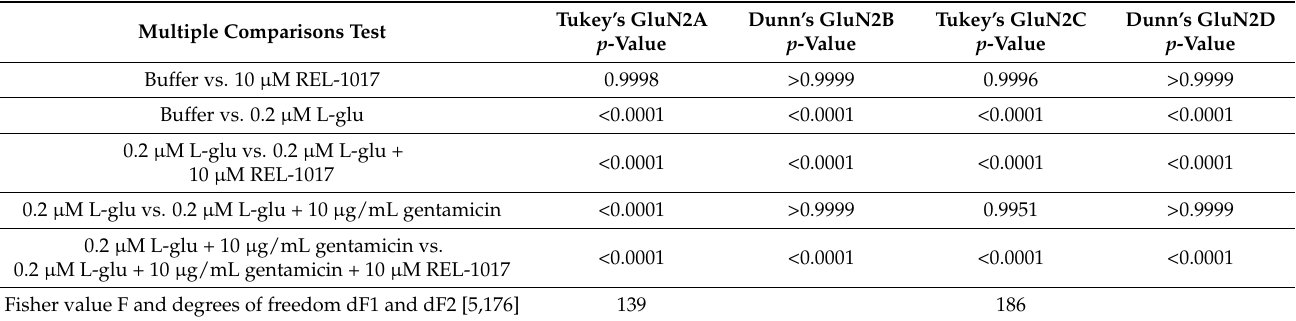
Table 5. Statistical significance of values reported in Figure